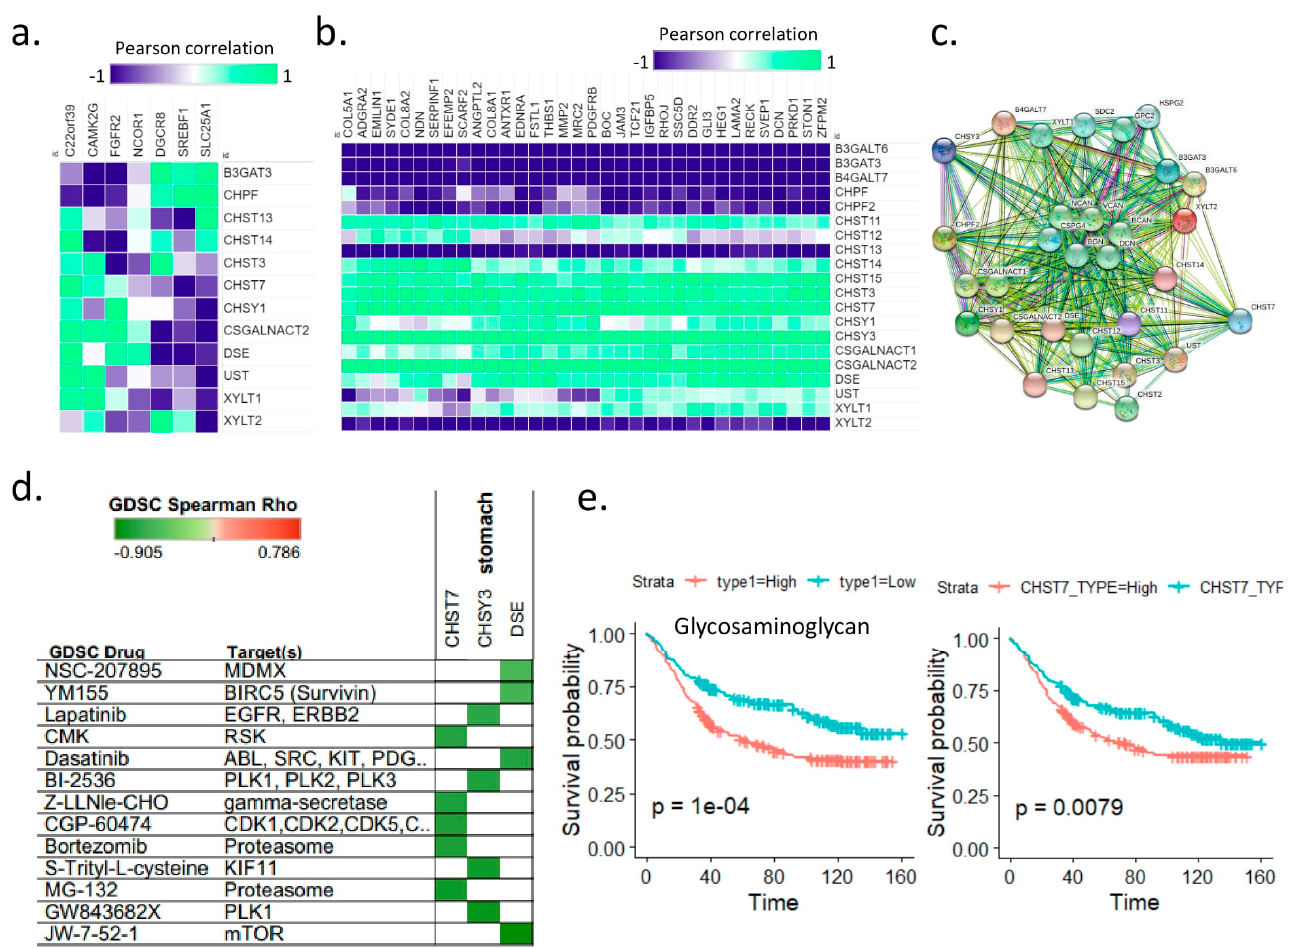
Figure 4. Therapeutic targets in the high-matrisome group in gastric cancer. ( a ) Heat map of Pearson correlation between high expression of glycosaminoglycan biosynthesis-chondroitin sulfate genes and that of 22q11.2 copy number variation pathway genes in cohort Y497. ( b ) Heat map of Pearson correlation between high expression of glycosaminoglycan biosynthesis-chondroitin sulfate genes and that of angiogenesis development genes in cohort STAD. ( c ) Network of protein–protein interaction in glycosaminoglycan biosynthesis-chondroitin sulfate in cohort Y497. ( d ) Predicted drugs from Genomics of Drug Sensitivity in Cancer database for CHST7 , CHSY3 , and DSE . ( e ) Kaplan–Meier plots for glycosaminoglycan biosynthesis-chondroitin sulfate gene signatures (left) and CHST7 expression in Y497. STAD, The Cancer Genome Atlas stomach adenocarcinoma.